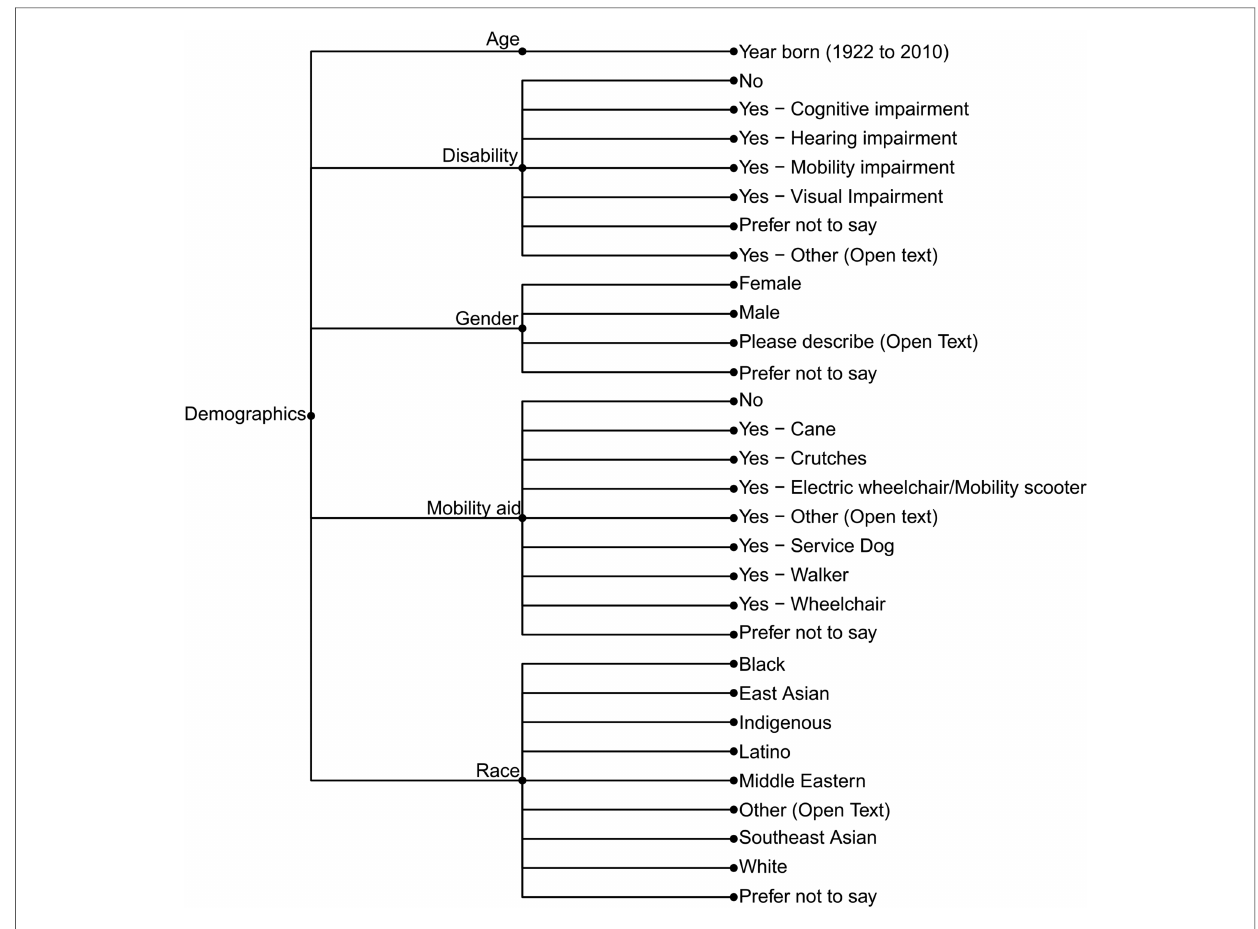
FIGURE 5 Demographic data collected on WalkRollMap.org survey.